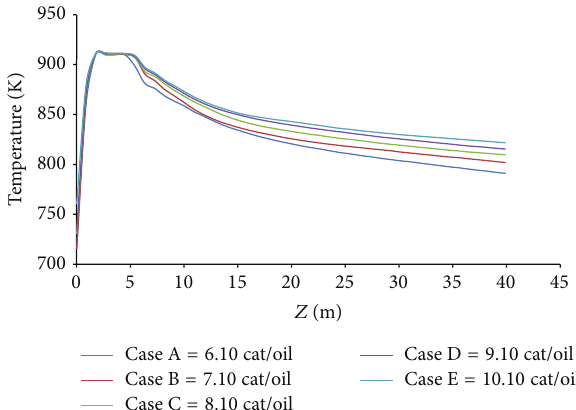
Figure 20: Comparison of the product yields for catalyst-to-oil